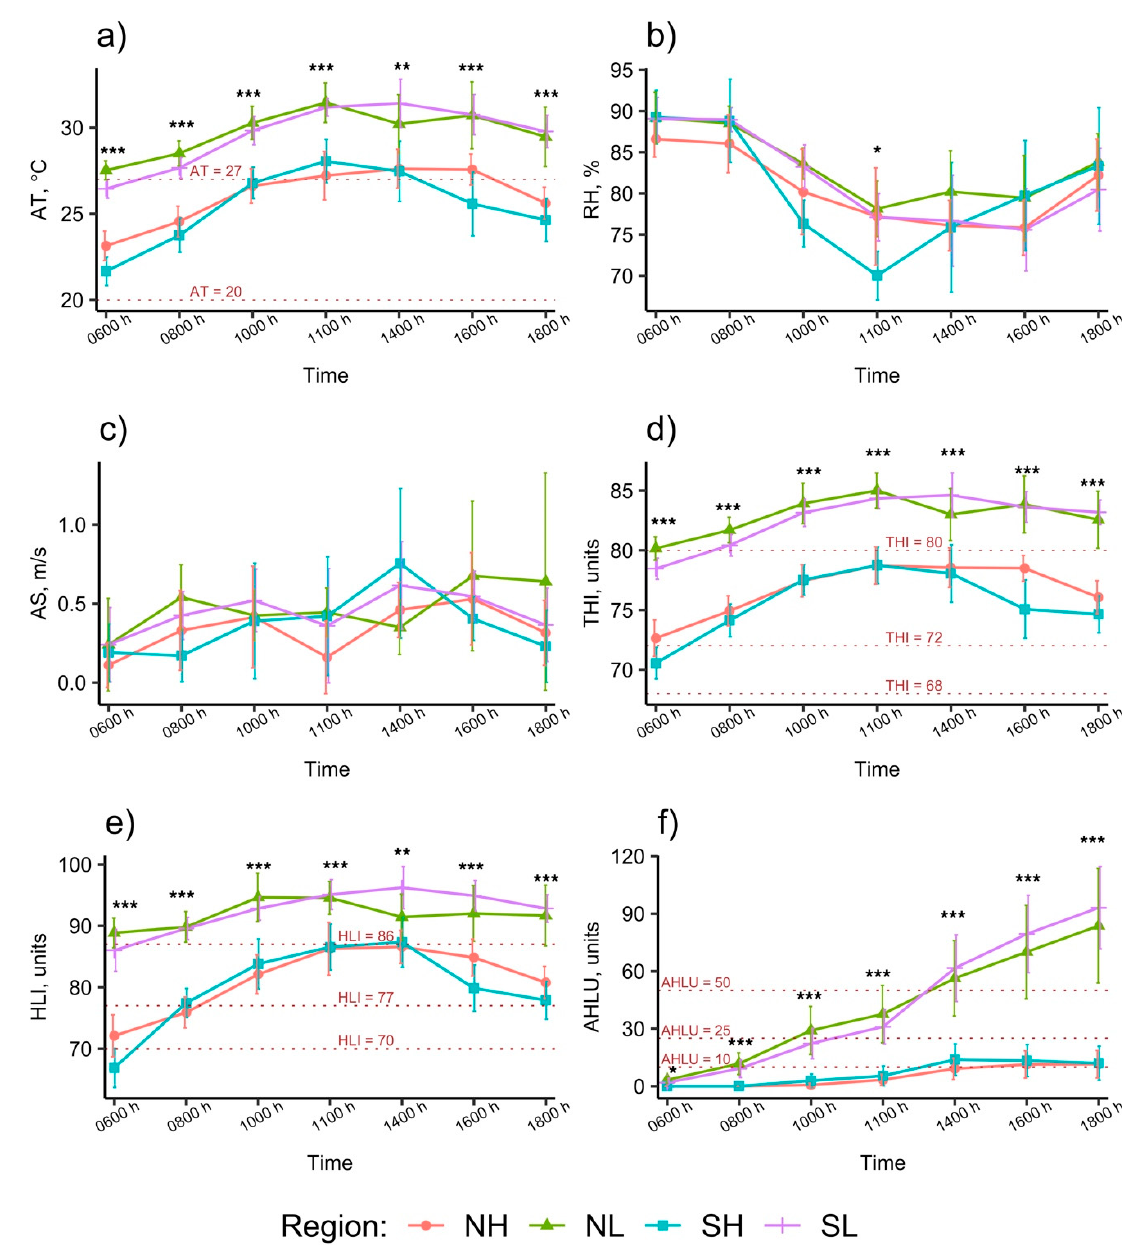
Figure 3. Changes of means of some main microclimate parameters in four regions during day time. ( a ) Dry-bulb temperature (AT), ( b ) Relative humidity (RH), ( c ) Air speed (AS), ( d ) Temperature-humidity index (THI), ( e ) Heat load index (HLI), ( f ) Accumulate heat load units (AHLU). Error bars represent confident intervals; Significant levels: *, p < 0.05; **, p < 0.01; ***, p < 0.001. AT: no thermal stress, AT < 20; heat stress threshold, 20 ≤ AT < 27; mid-severe heat stress, AT ≥ 27 [33–35]. THI: normal, THI < 68.0; heat stress threshold, 68 ≤ THI < 72; mild-moderate heat stress, 72 ≤ THI < 80; moderate-severe heat stress, THI ≥ 80 [8]. HLI: cool, HLI < 70; moderate, 70 ≤ HLI < 77; hot, 77 ≤ HLI < 86; very hot, HLI ≥ 86 [6]. AHLU: low, AHLU < 10; moderate, 10 ≤ AHLU < 25; high, 25 ≤ AHLU < 50; very high heat load, AHLU ≥ 50